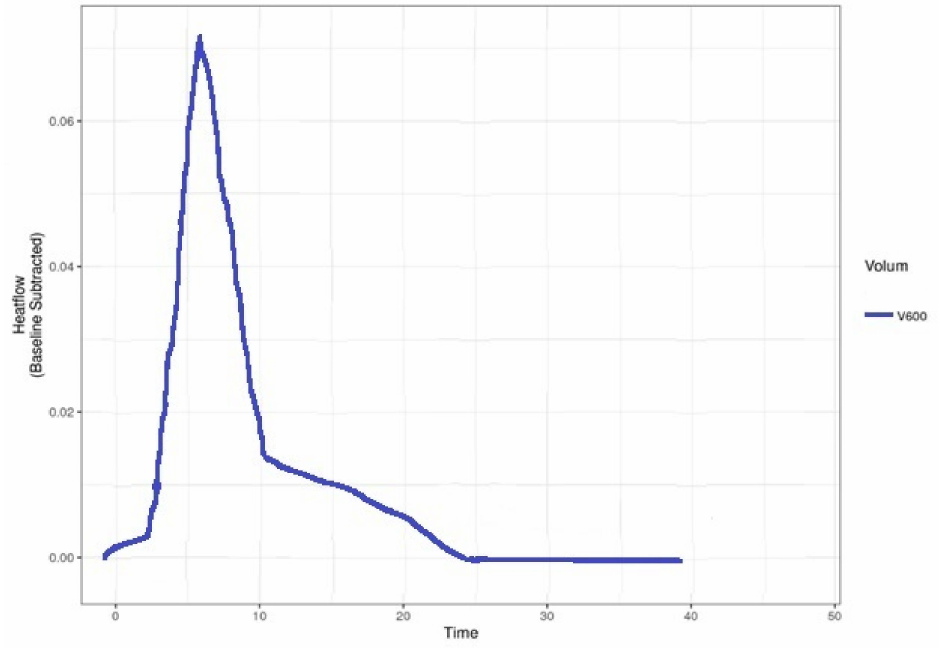
Figure 7. Graphical representation of the growth curve generated by the heat released by the active metabolism of S. epidermidis—P1 . Experiments performed at 37 ◦ C and with a microcalorimetric cell load of 600 µ